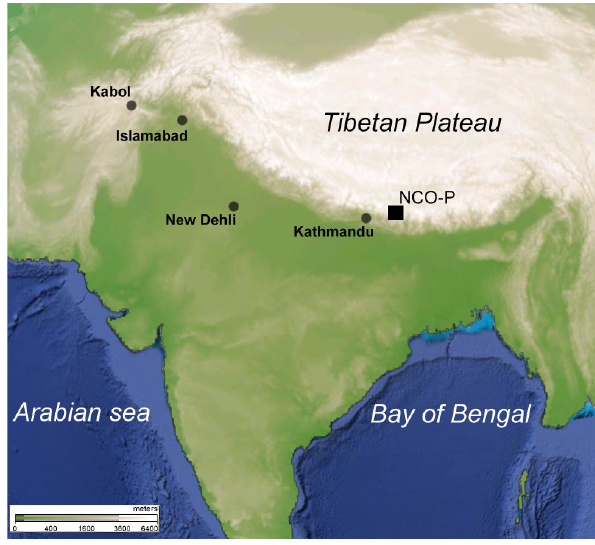
Fig. 1. NCO-P geographical location. Adapted from www.